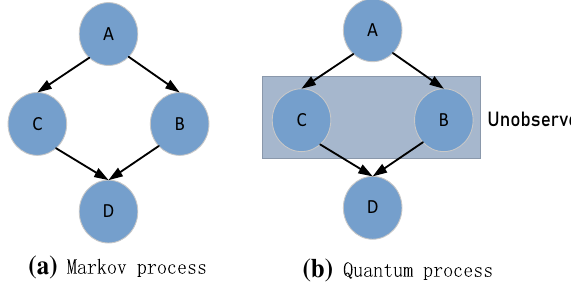
Fig. 2 Path selection of decision state